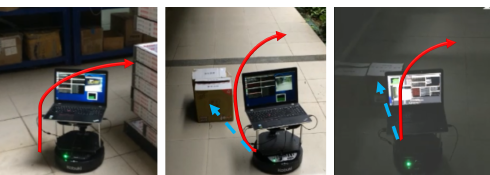
Figure 13. Left figure, turning at the corner; mid figure, obstacle avoidance in morning; Right figure, obstacle avoidance at night. The blue dotted array is the motion before avoidance, and the red array is the motion during obstacle avoidance.